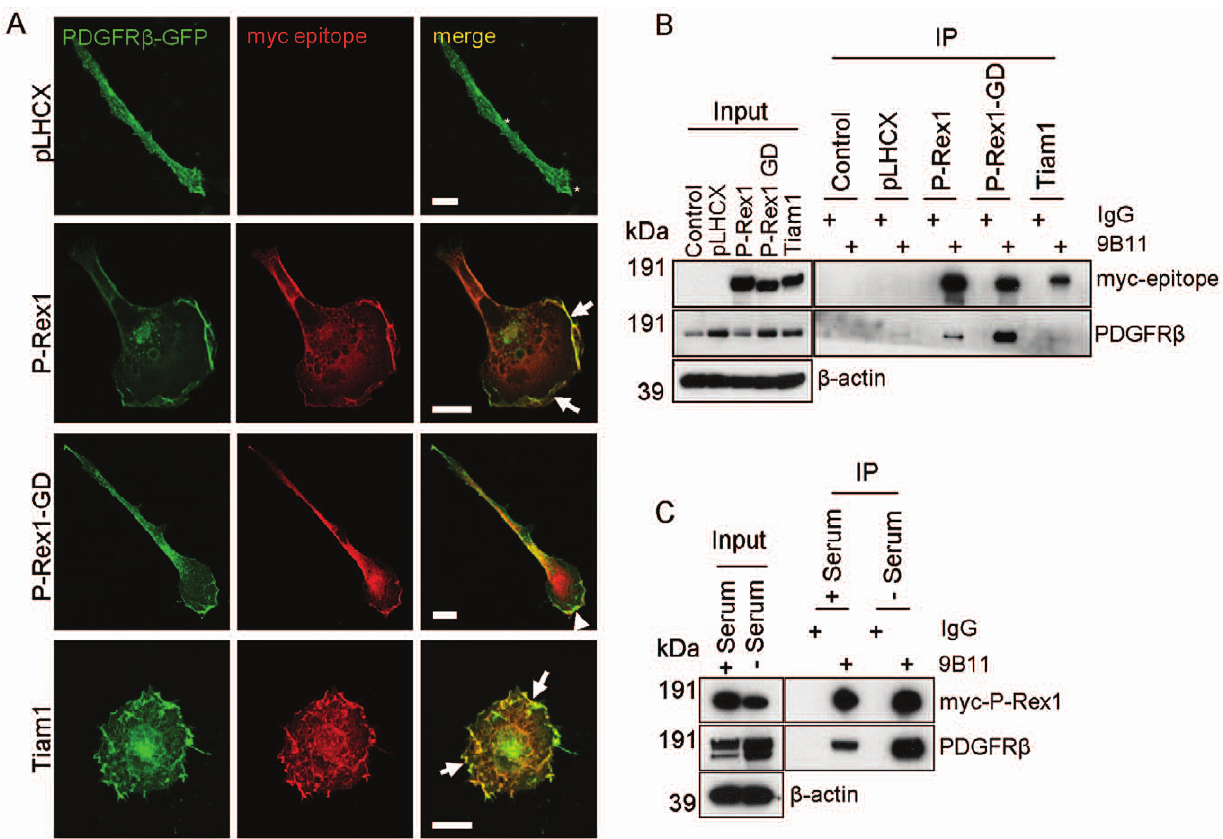
Figure 5. Association of P-Rex1 with PDGFR b from immortalised human fibroblasts. (A) Control vector (pLHCX) or myc-RacGEF expressing immortalised human fibroblasts were transfected with GFP-tagged PDGFR b and plated onto glass cover slips. Cells were fixed and the myc-tagged RacGEFs were stained by immunofluorescent labelling with an antibody recognising the myc-epitope followed by AlexaFluor-555 conjugated secondary antibodies. (B, C) Myc-tagged RacGEFs were stably expressed in immortalised human fibroblasts. The cells were then grown in serum- containing medium (B) or serum-starved for 18 hr (right hand lanes in (C)) prior to lysis in a buffer containing 0.15% Tween-20. Myc-tagged RacGEFs were immunoprecipitated from lysates using an antibody recognising the myc-epitope, and immunoisolated material was probed for the presence of PDGFR b by immunoblotting.